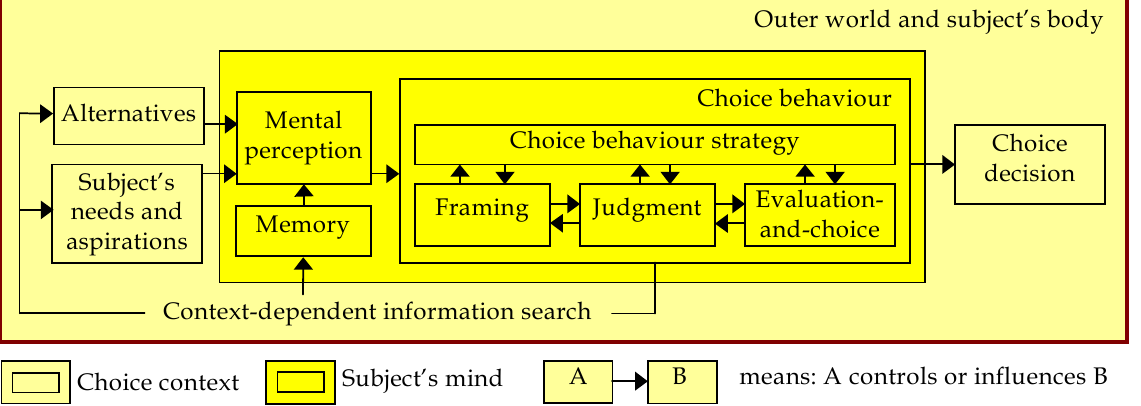
Figure 1. A functional-descriptive framework model of human choice